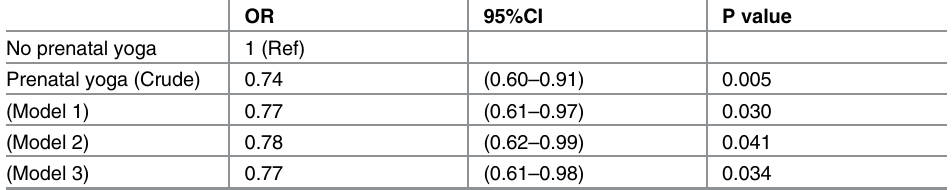
Table 2. Adjusted odd ratios for ritodrine hydrochloride use.